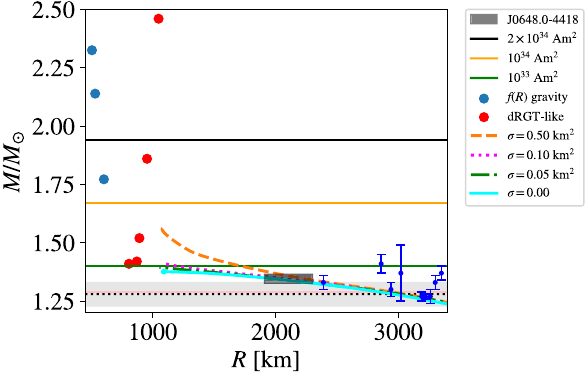
Fig. 6 Same as Fig. 5, but considering the 16 O threshold for equation of